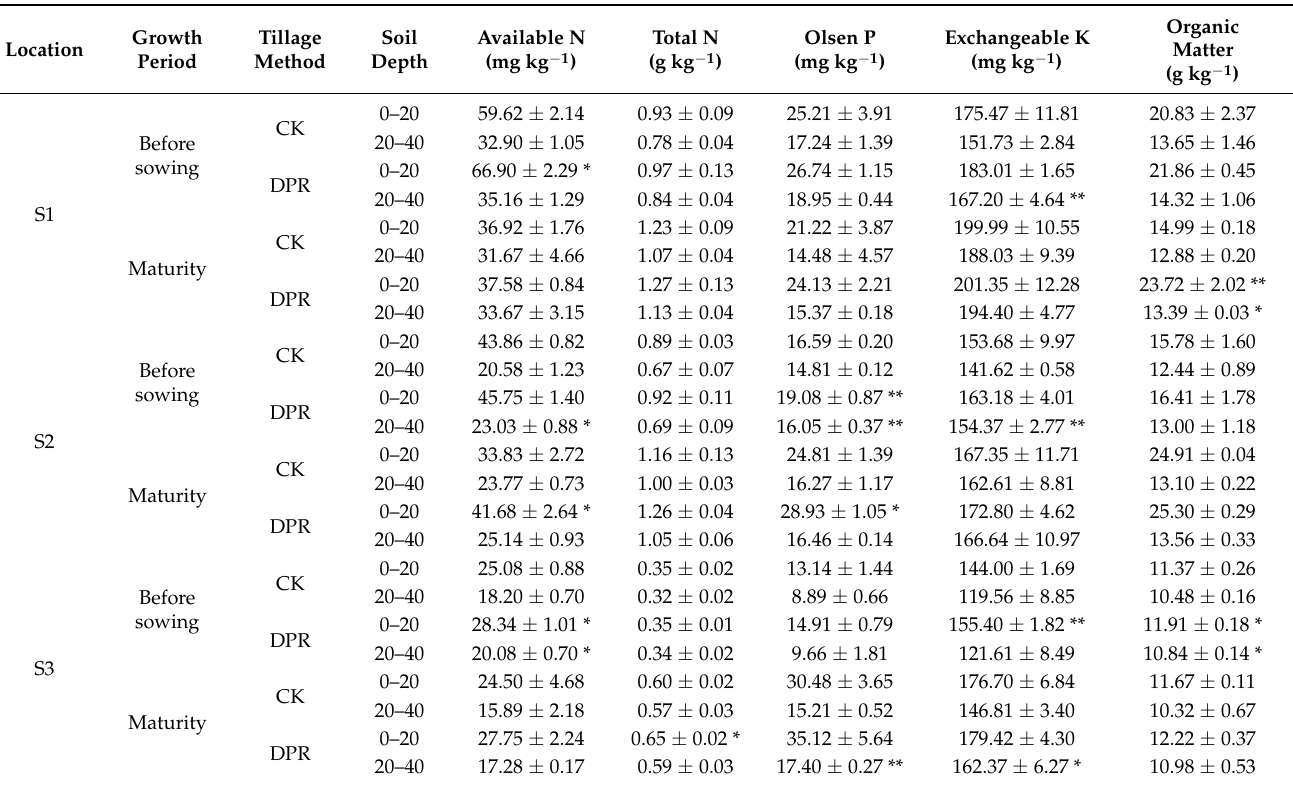
Table 3. Effects of deep straw return on soil nutrient